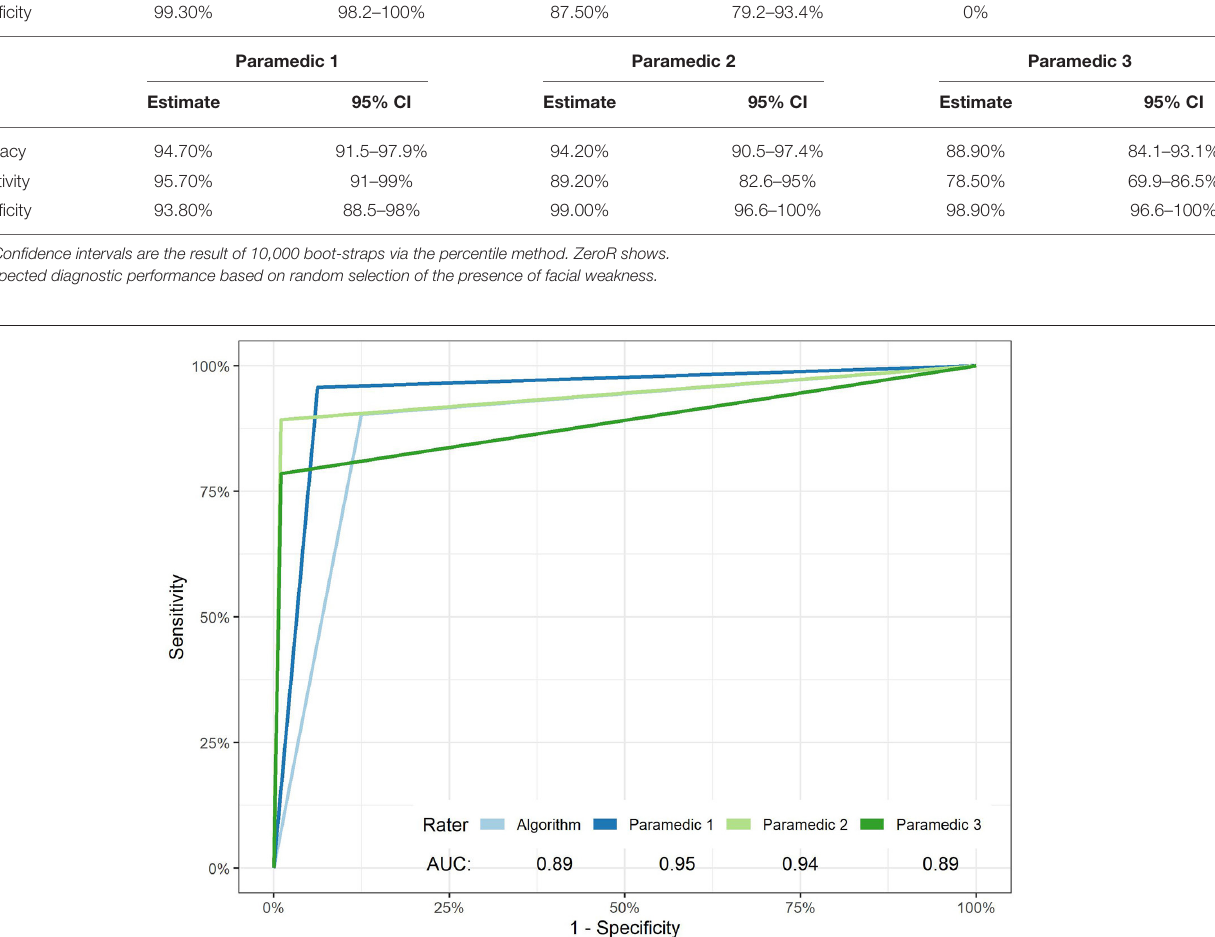
the sensitivity but not the specificity of the paramedic